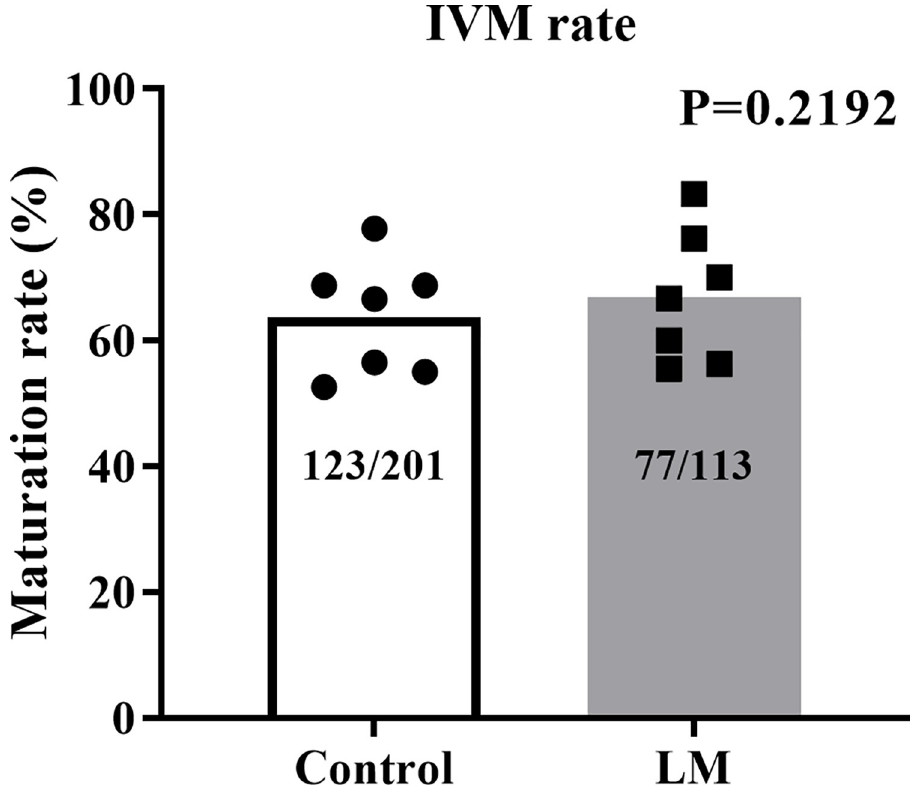
Fig 2. In vitro maturation rates. Nuclear maturation rate of oocytes cultured in conventional (control; 61.19%, 7 replicates) or in LM (68.14%, 7 replicates) systems. Within the bars there are mature/total oocytes numbers. Analysis were performed by Chi-square test with a statistical, no statistical difference was found between the groups (P >